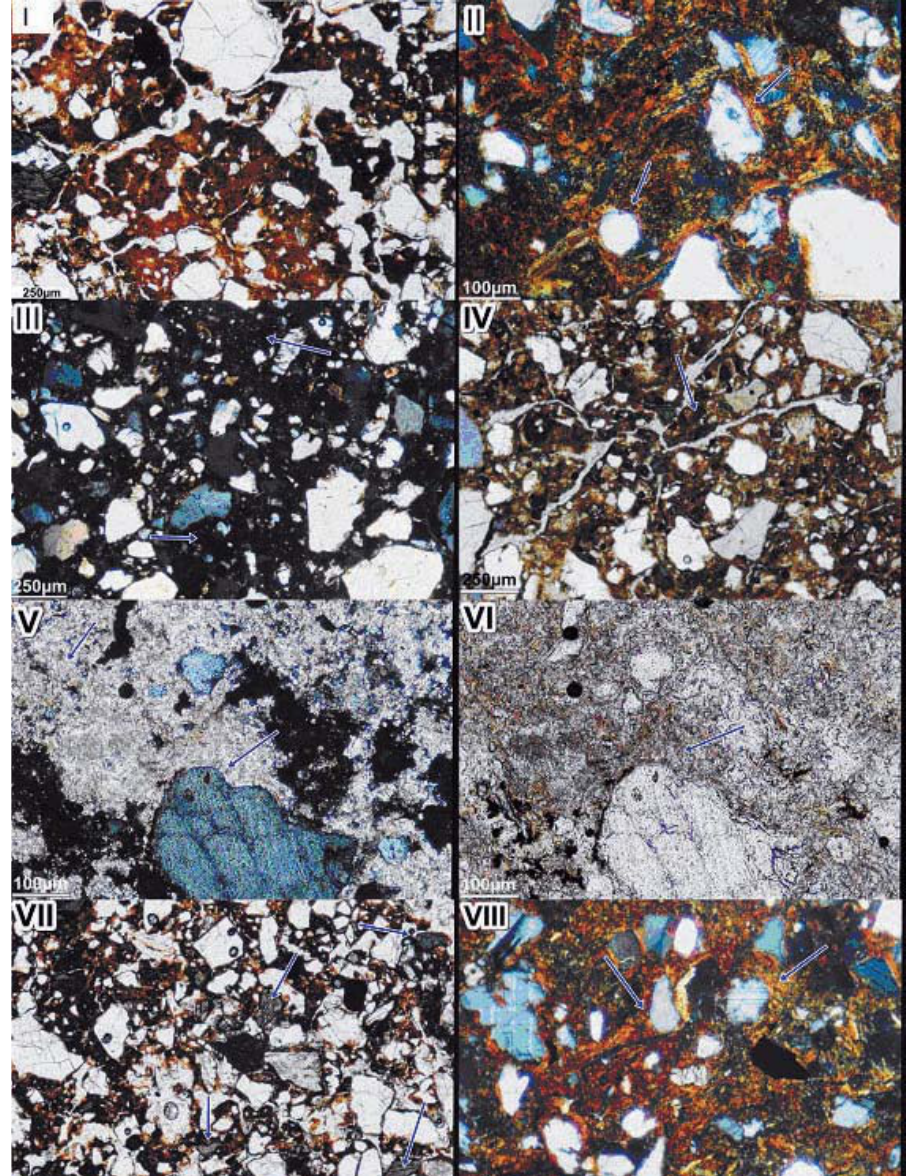
Figura 1. Fotomicrografias mostrando: padrão de distribuição relacionado (PDR) do tipo porfírico e b-frabric granoestriado dos horizontes Bt e BC do perfil 1 (I e II) e Bt do perfil 3 (VIII); escurecimento da matriz por matéria orgânica no horizonte A (III), parte da estrutura em blocos angulares do horizonte Bt (IV) e alteração de feldspatos produzindo calcita (V e VI) no horizonte BC do perfil 2; grãos (verdes) de hornblenda e estrutura do tipo complexa no horizonte A do perfil 3